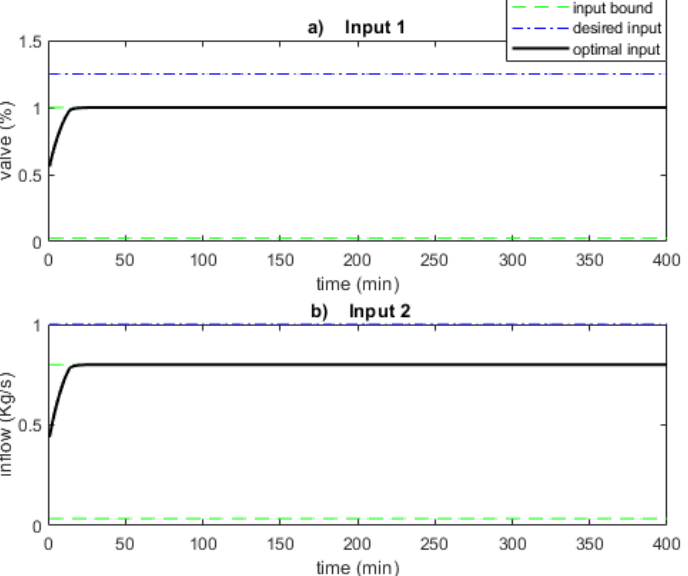
Figure 15. Optimal inputs when the desired inputs are out of input bounds. The two inputs saturated on the upper boundary of the control input even when disturbance arrived. This helped the attenuated disturbance effect very quickly.